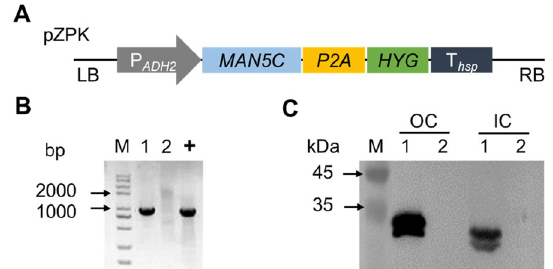
Fig. 2 Engineering R. toruloides NP11 for MAN5C secretory expression. A Schematic of MAN5C expression cassette; B PCR result for MAN5C gene verification using the genomic DNA as templates; C Western blot analysis of the recombinant MAN5C. Lane M: Marker; Lane 1, 2: Represent samples from NP11-MAN5C and NP11, respectively; Lane : The plasmid pZPK-P ADH2 - MAN5C -P2A- HYG -T HSP ; + OC, IC: Represent the protein samples from the culture supernatant and cell lysates,